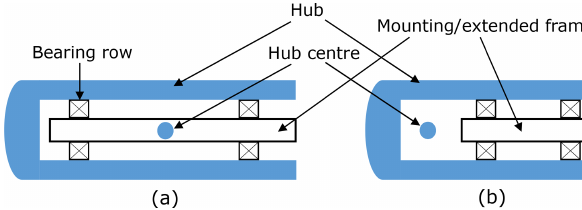
Figure 2. Hub and main-bearing configurations studied in the cur- rent paper. Throughout the paper, these will be referred to as (a) cen- tred support and (b) overhung